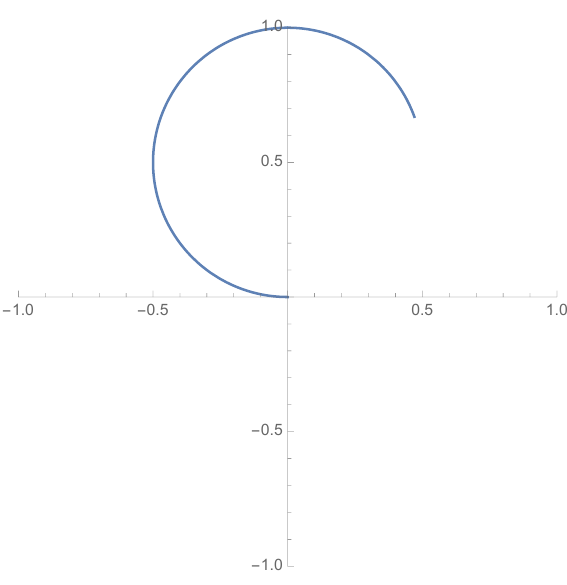
Figure 1 . Argand diagram for the phase shift in the J=2 channel.